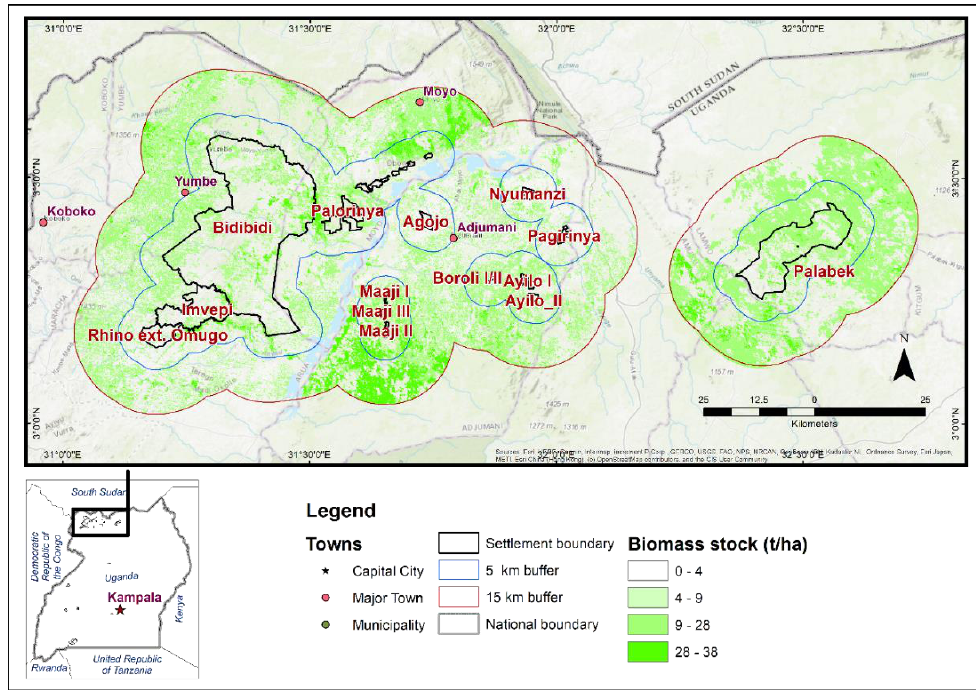
Figure 4. Biomass stock within the AoIs in northern Uganda, early 2018. Source: World Bank and FAO, 2020a [29].